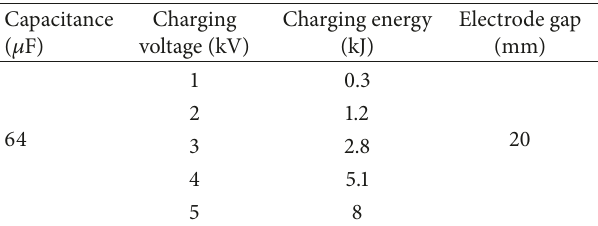
Table 3: EHF conditions.